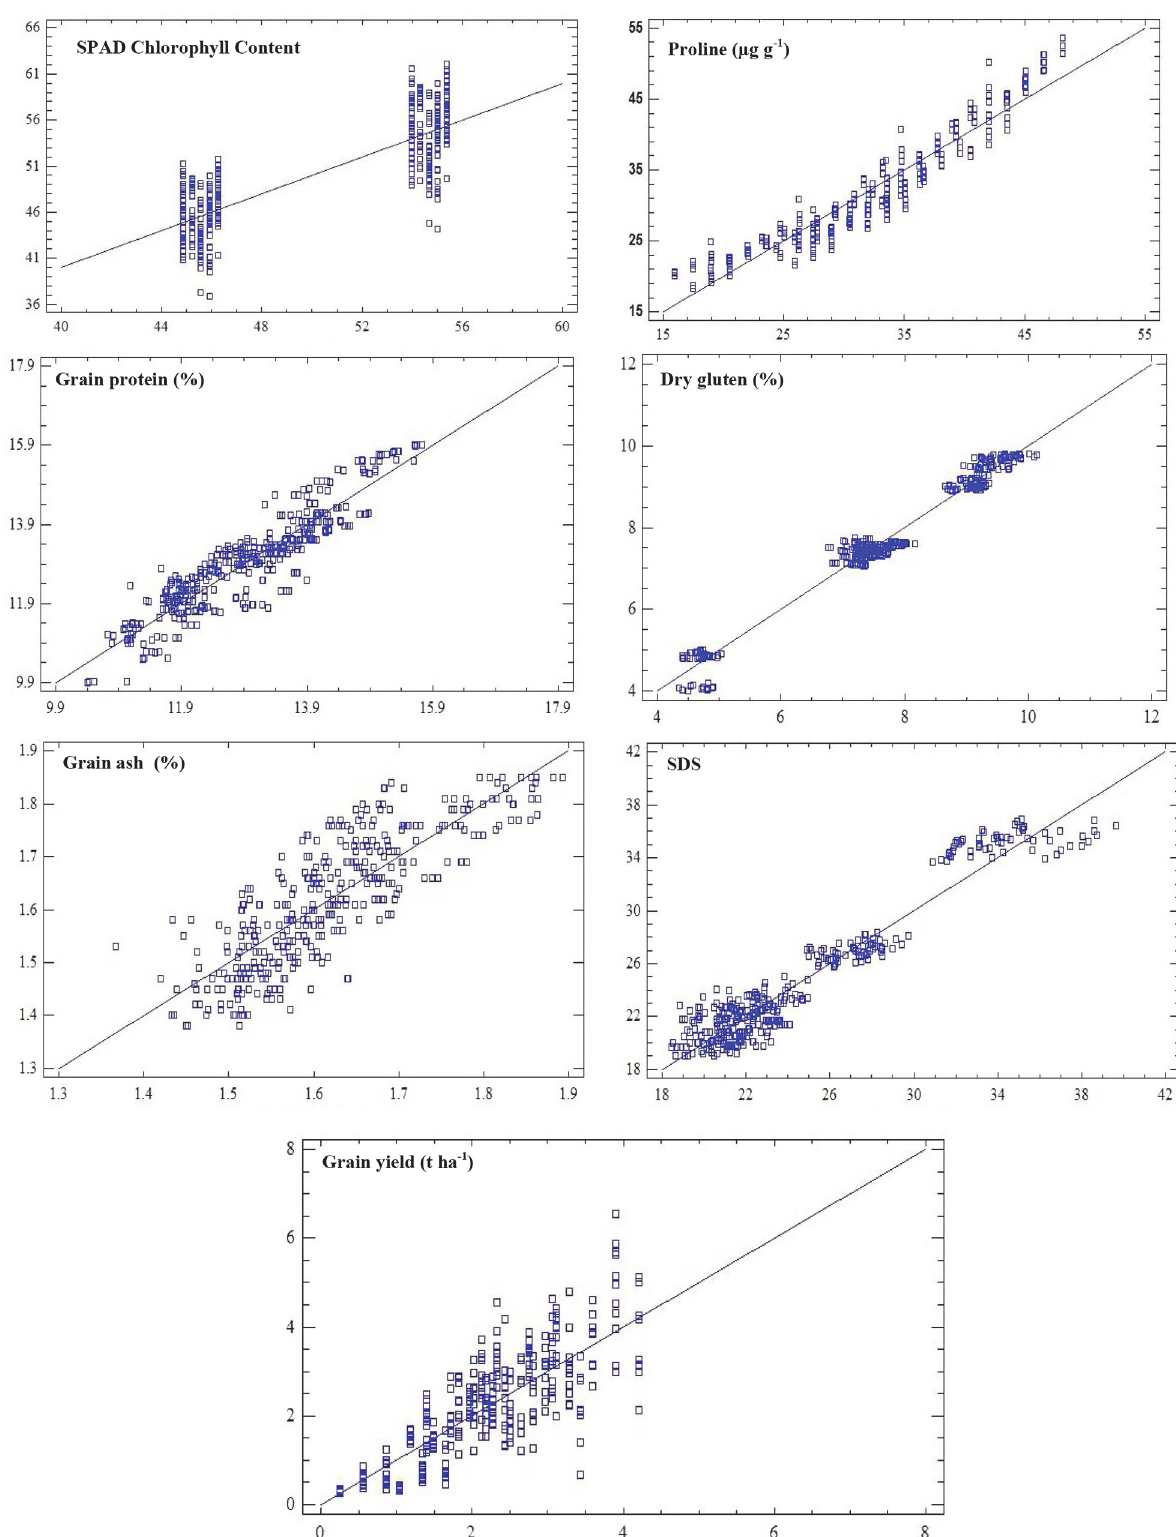
Fig 3. 1:1 relationship among simulated (x-axis) and observed (y-axis) physiological, grain quality traits and grain yield in response to